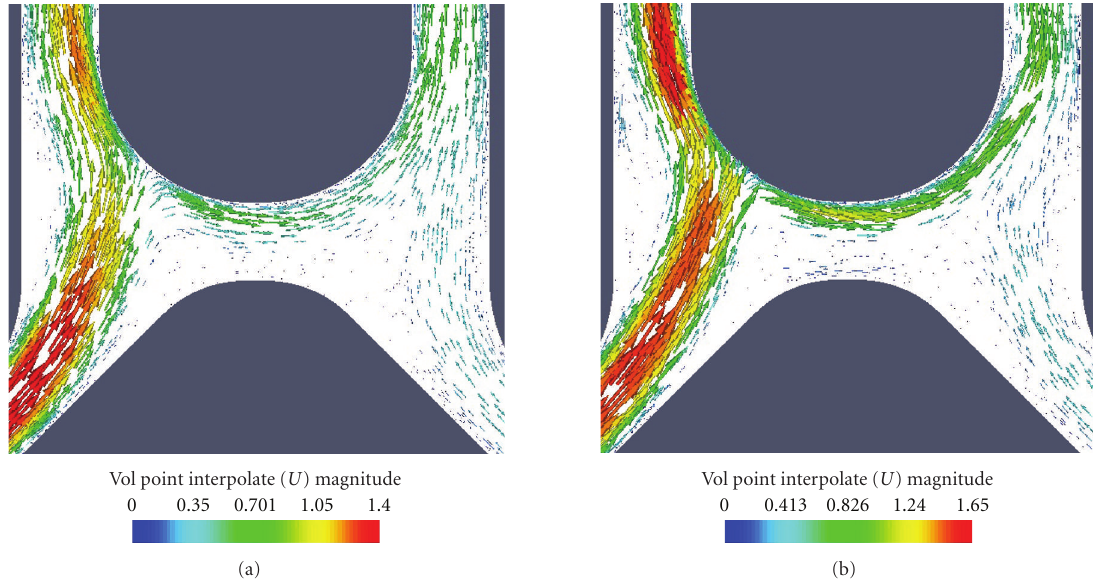
Figure 6: (a) Velocity field during systole and (b) early diastole with ACA flow rates set at Q R = 0 . 25 Q L . Bifurcation of the A1 parent flow artery into the ACOM and A2 segments is again seen. Left ACA impingement site appears to move even further rightward along A2-ACOM adjoining wall compared to that seen in the case where Q R = 0 . 33 Q L . Flow separation is again seen on the right A2-ACOM impingement site leading to local recirculation e ff ects.